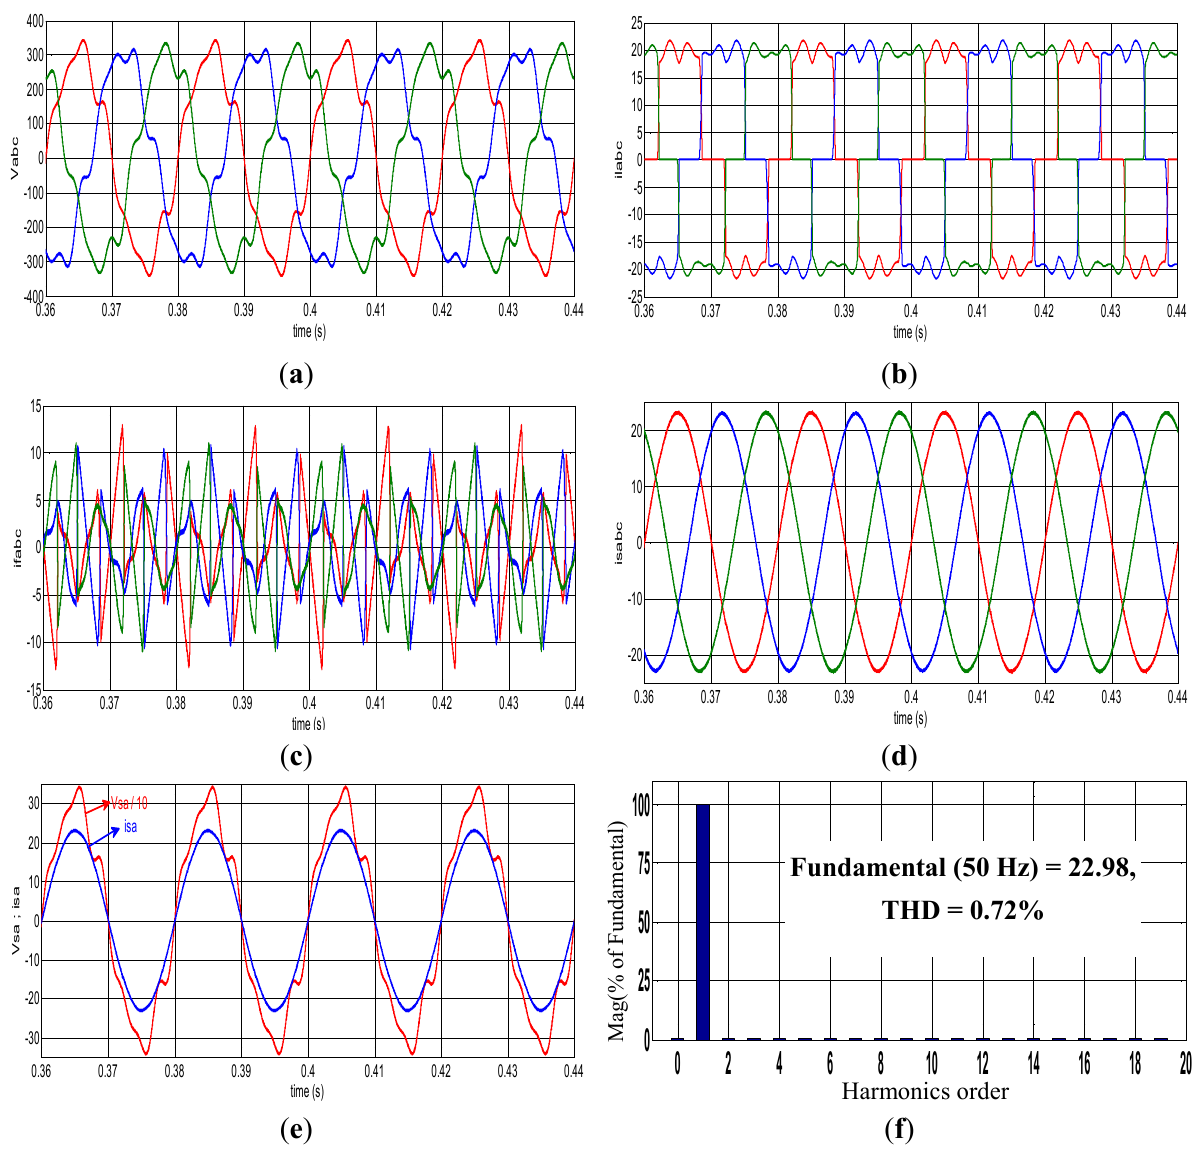
Figure 14. Simulation results for balanced distorted grid voltage: ( a ) three-phase line voltages; ( b ) three-phase load currents; ( c ) three-phase filter currents; ( d ) three-phase line currents; ( e ) line voltage and current, phase-a; ( f ) frequency spectrum of line current,